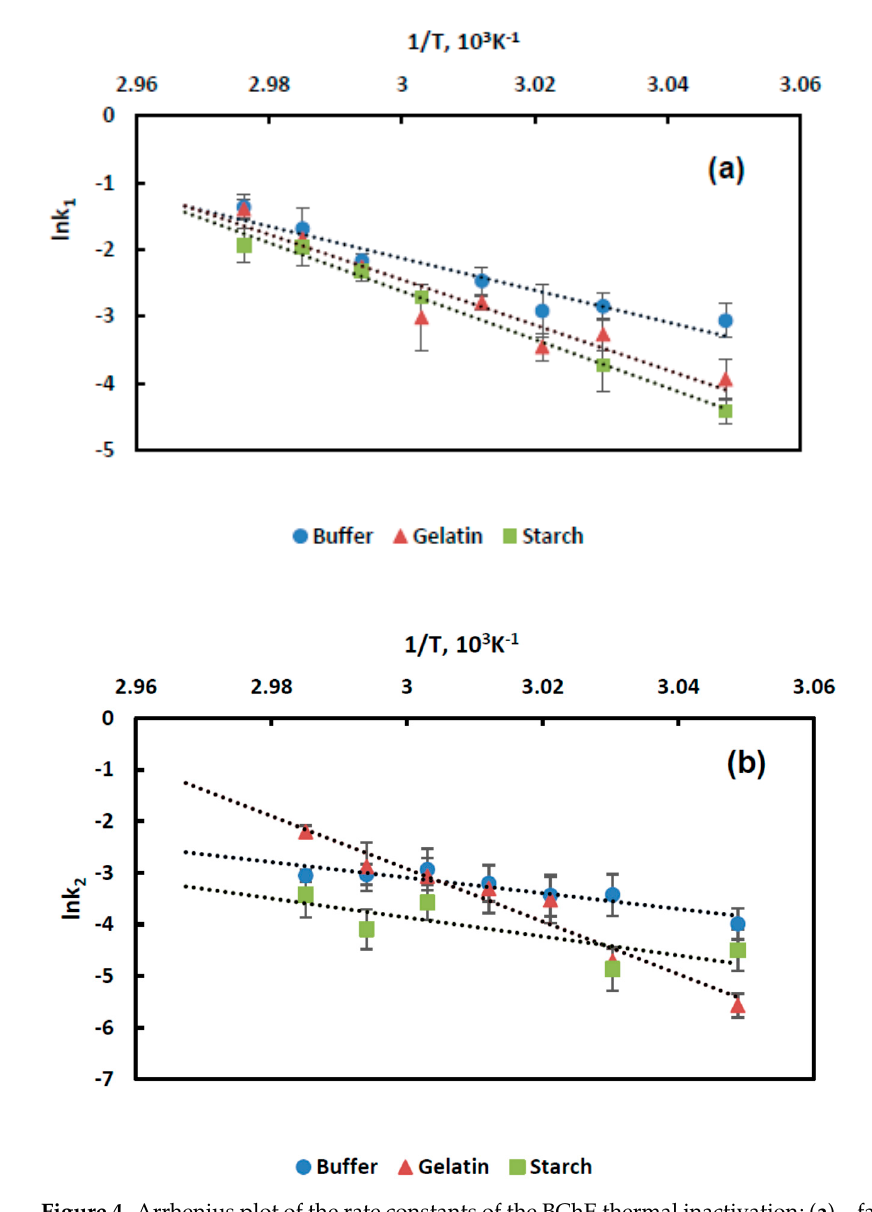
Figure 4. Arrhenius plot of the rate constants of the BChE thermal inactivation; ( a )—fast rate constant k 1 , ( b )—slow rate constant k 2 . Table 1. Activation parameters for thermal inactivation of